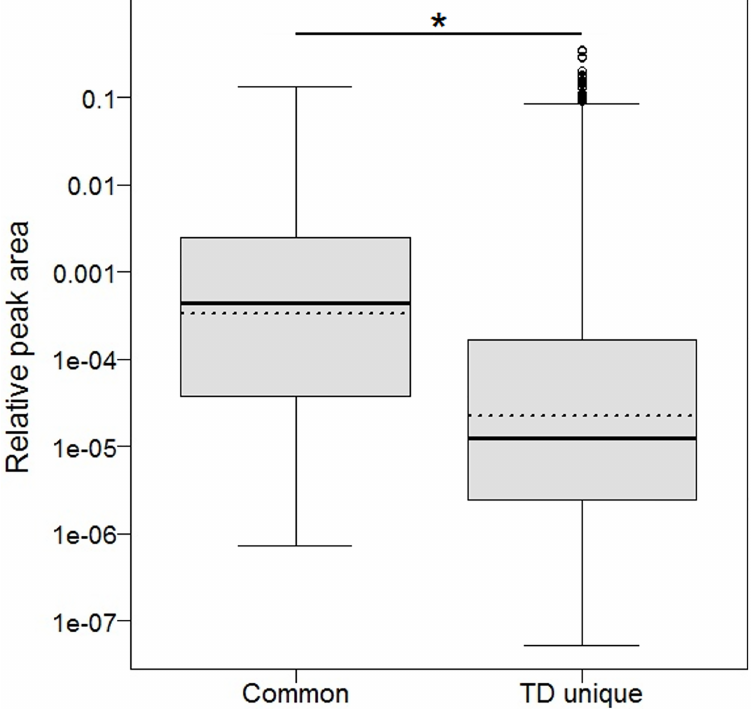
Fig 1. Comparison of TD tube peaks which are in common with the mobile GC-MS and occurring only in TD. Box-and-whisker plots of the relative peak areas from integrationof TD tubes Mix peaks in common with the mobileGC-MS samples (left, Median common = 4.25 x 10 -4 , N common = 183) and peaks which are uniquefor TD tubes Mix (right, Median TD = 0.12 x 10 − 4 , N TD = 9217). Bold, solid lines indicatemedians,boxes range from the lower to the upper quartiles, lower whiskers are definedas max(min(x), Q_1–1.5 * IQR), upper whiskersequal min(max(x), Q_3 + 1.5 * IQR), open circles are outliers, dotted lines depict the means and asterisk indicatesthe significantdifference. The relativepeak areas were log transformed, the y-axis of the plot is on originalscale.